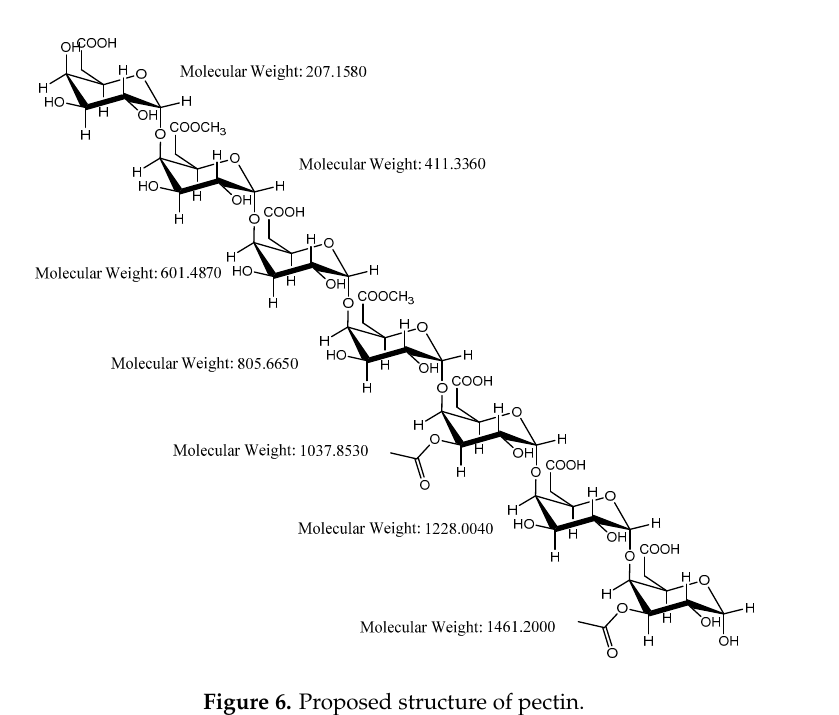
Figure 6. Proposed structure of pectin.